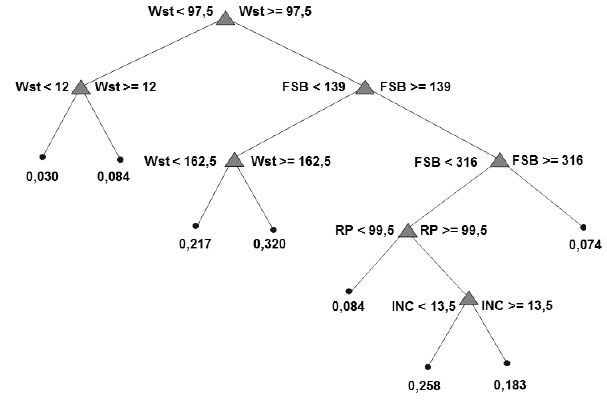
Fig. 5. Regression tree RT2 with eight leaves for estimating